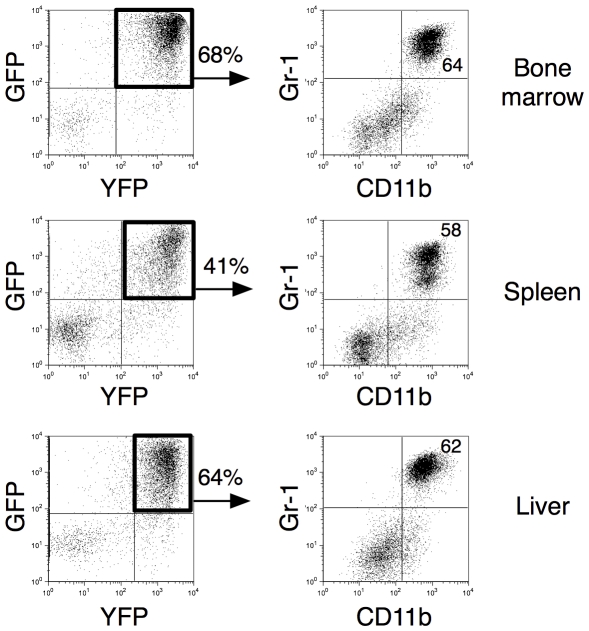
Overexpression of BCL-XL-GFP/MYC-YFP induces AML.Flow cytometry analysis of bone marrow (top), spleen (middle) and liver (bottom) cells from one representative moribund BCL-XL-GFP/MYC-YFP mouse. Single cell suspensions from femoral bone marrow, spleen and liver were stained with anti-CD11b and anti-Gr1. The percentage of dominating cells is indicated.